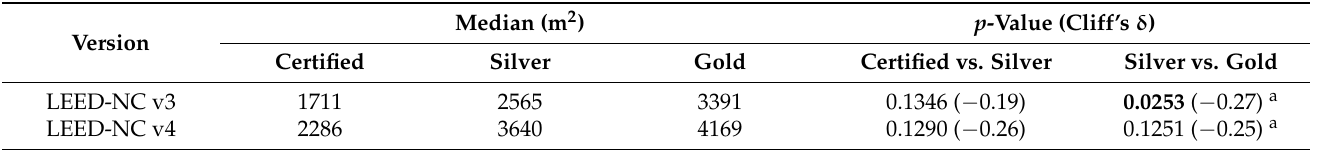
Table 5. LEED-NC v3/v4 office-type projects: LEED project sizes and results of the statistical analysis. Median (m 2 ) p -Value (Cliff’s δ Version